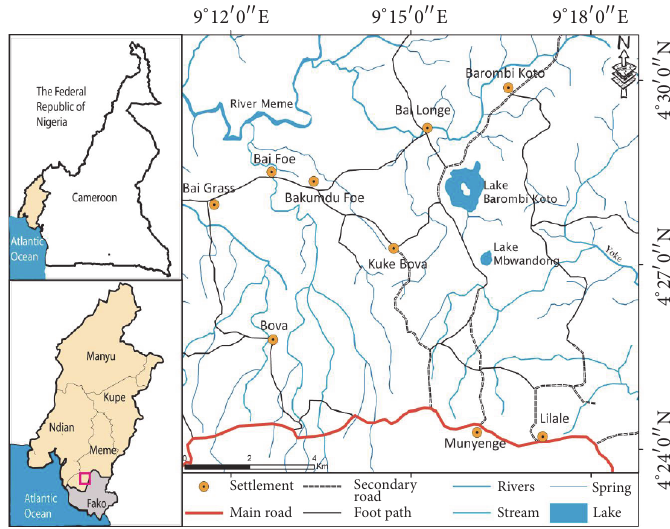
Figure 1: Map showing the location of Munyenge in Mount Cameroon